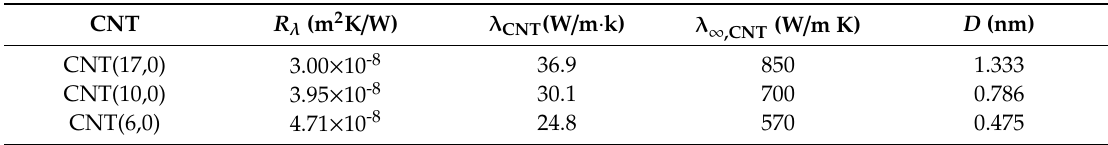
Table 2. Parameters used in e ff ective medium approximation (EAM) theory for prediction of thermal conductivities of PA-6,6 / CNT nanocomposite.*.